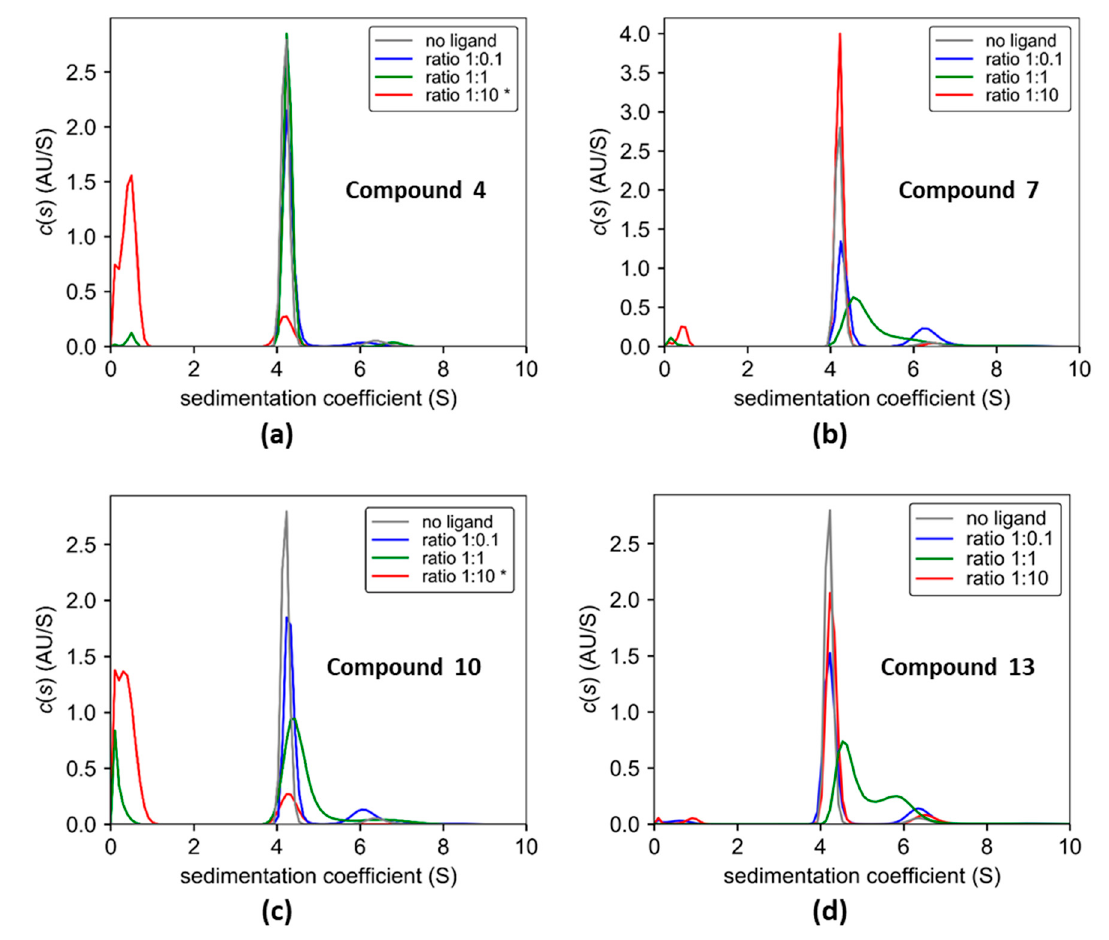
Figure 4. Continuous c(s) distributions of PA-IL samples obtained in the absence and presence of multivalent galactosylated dendrimers. The distributions were obtained at different protein to ligand ratios (see the legend). The c(s) curves obtained at 294 nm (instead of 280 nm) are marked with a star. ( a ) Results for compound 4 ; ( b ) Results for compound 7 ; ( c ) Results for compound 10 ; ( d ) Results for compound 13 .